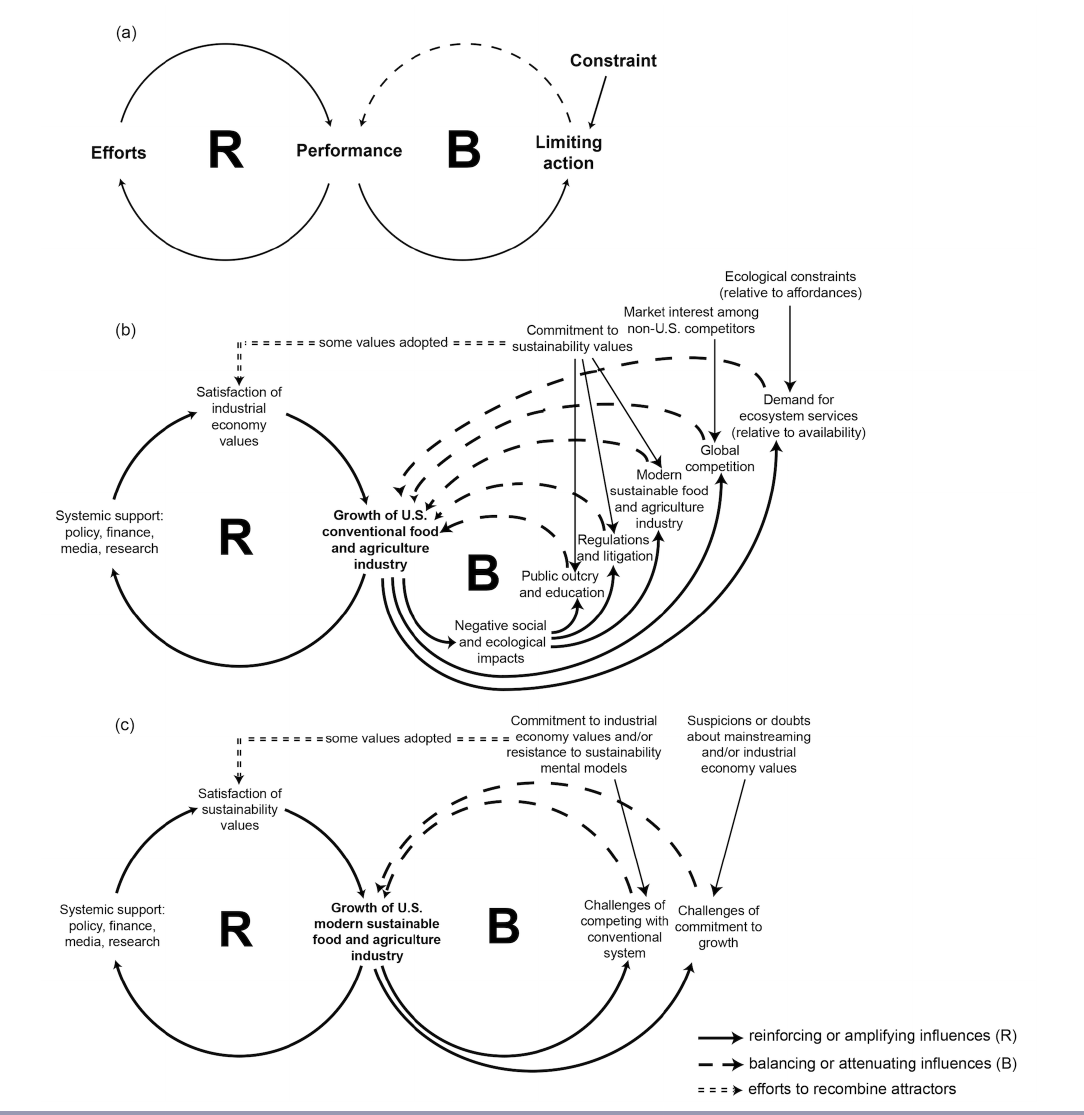
Fig. 2 . Contending dynamics, reinforcing and attenuating. Fig. 2a shows the original “limits to growth” or “limits to success” archetype, redrawn from Senge (1990:97) and Kim and Anderson (1998:43). Ecotrust (2005 a ) and Silverman et al. (2005) used this archetype in applied food-systems work, with Fig. 2b showing the reinforcement and attenuation of the “conventional” food-system regime, and Fig. 2c showing the reinforcement and attenuation of the “sustainable” food-system regime. Both Fig. 2b and 2c include a double dotted line at the top, a feature added by Silverman et al. (2005) to the original archetype to indicate efforts by regime proponents to adopt and integrate values from the contending regime. In effect, these regime proponents sought to strengthen affiliations through recombinations of attractors; i.e., transpositions of logics (Thornton et al. 2012). Fig. 2b and 2c were reviewed and redrawn for clarity and fidelity to the pattern of feedbacks in the original archetype; they are reprinted here with permission from Roots of Change